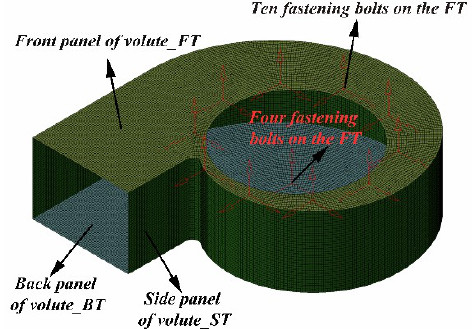
Figure 9. The finite element model (FEM) of the volute.